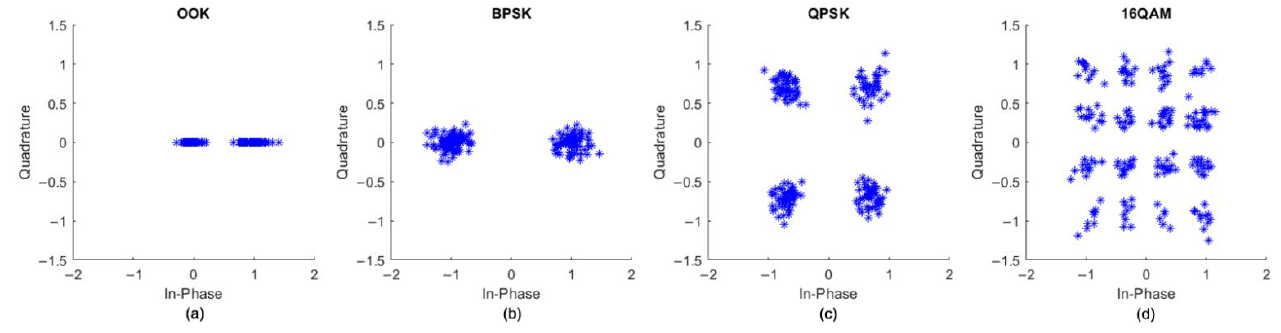
Figure 7. Constellation diagram of ( a ) OOK, ( b ) BPSK, ( c ) QPSK, and ( d ) 16 QAM.